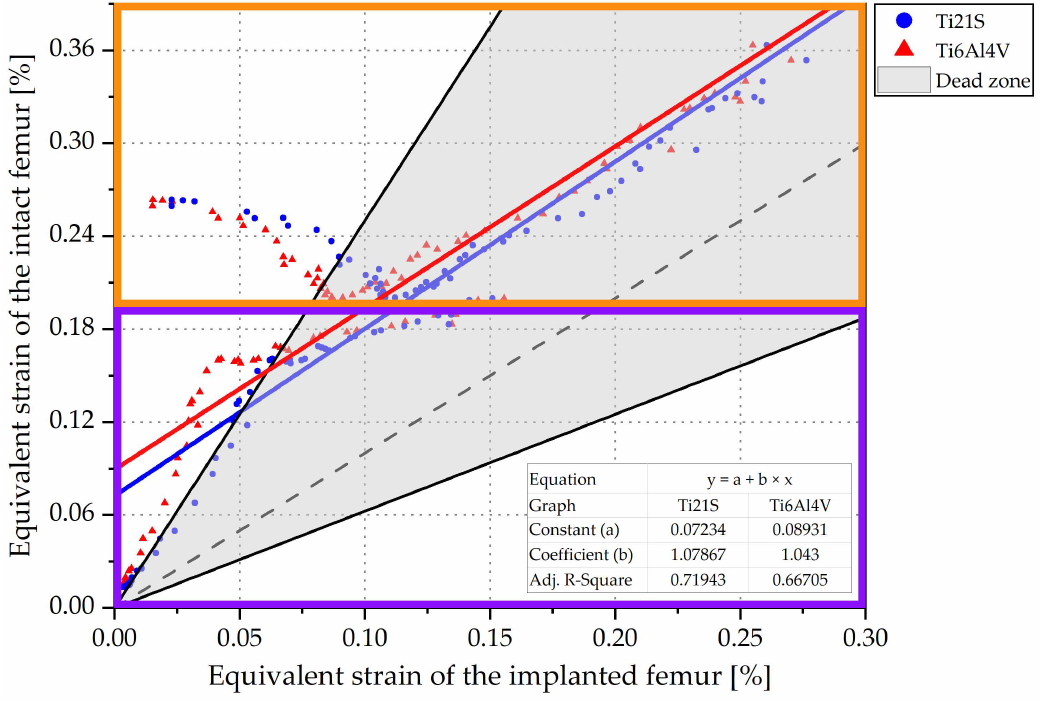
Figure 18. Regression graph of